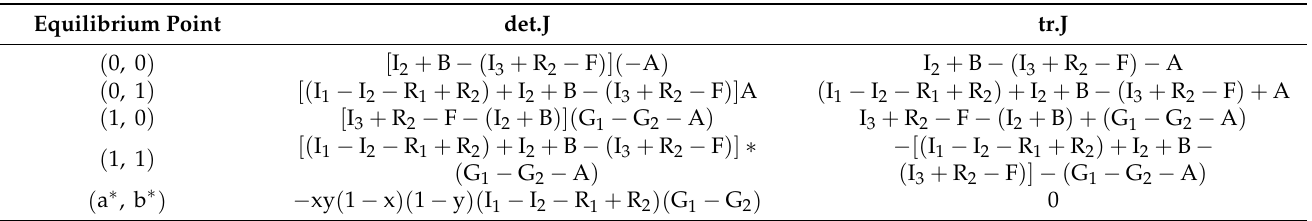
Table 6. Values of the determinant and trace of the Jacobi matrix of the game system between farmers and local government. det.J tr.J